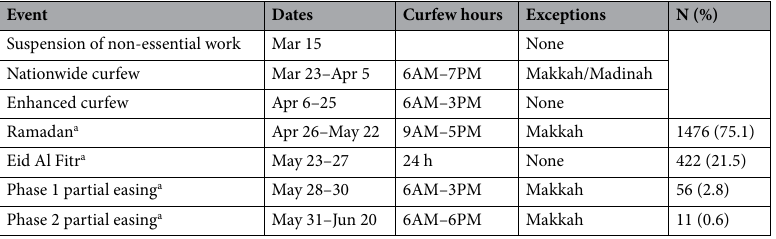
Table 1. Timeline of Events. a Denotes events that unfolded during the study period (May 11–June 6,